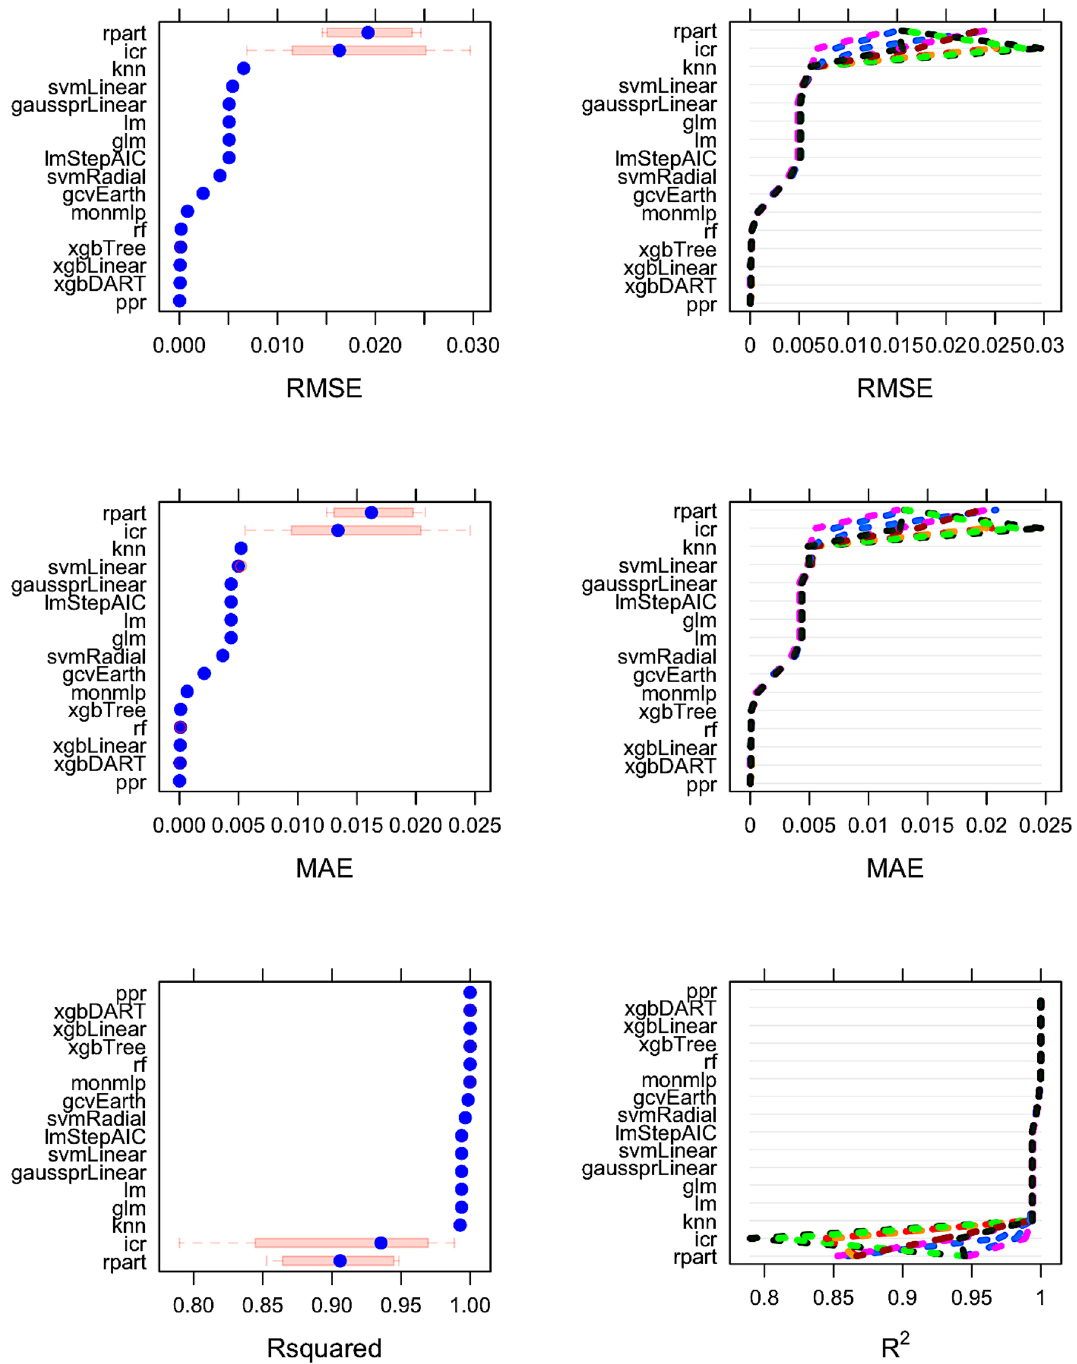
Figure 5. Observing RMSE, MAE, R 2 of each model constructed over the training data using Plot Vertical Box-and-Whisker plots. The tenfold cross-validation results of each model using various metrics are shown in this figure. icr and rpart tend to build models with high variance. Considering the experimental results, the best performing ML algorithm on the training data is ppr. rpart has the worst MAE, RMSE and R 2